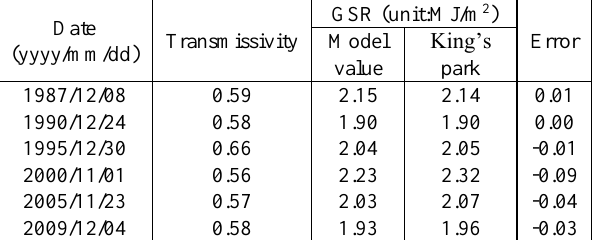
Table 4. A comparison between observed and simulated GSR